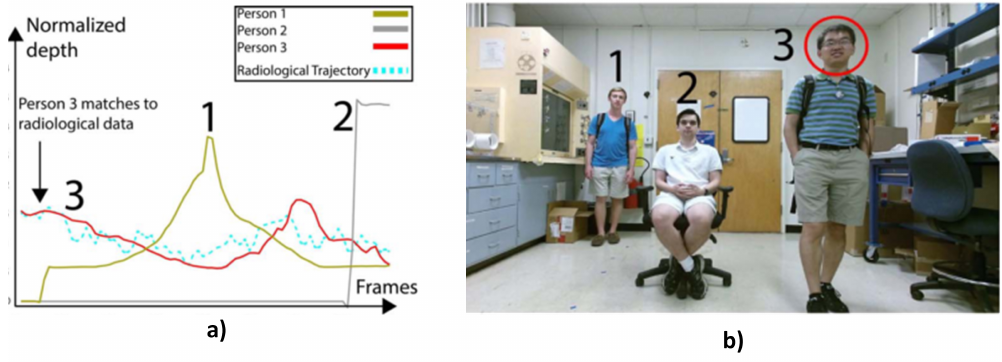
Figure 3. ( a ) Normalised depth trajectories of three targets and a radiation source (light blue); ( b ) image of targets with the suspect highlighted